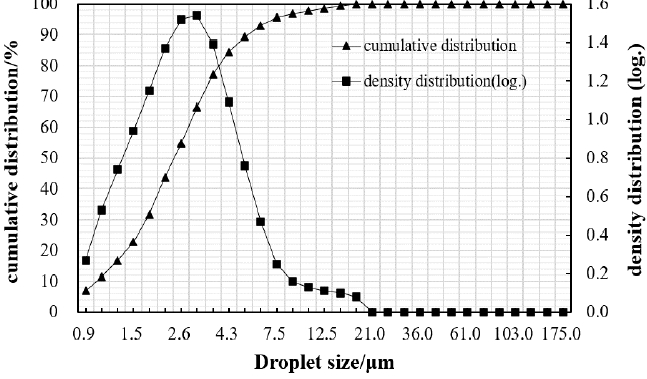
Figure 1. The droplet size distribution of asphalt emulsion.